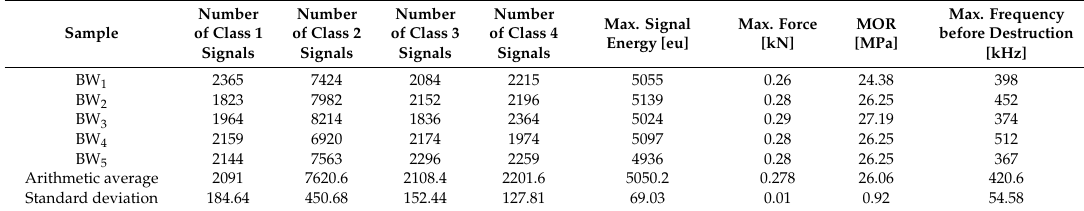
Table 5. Summary of research results for BW samples.